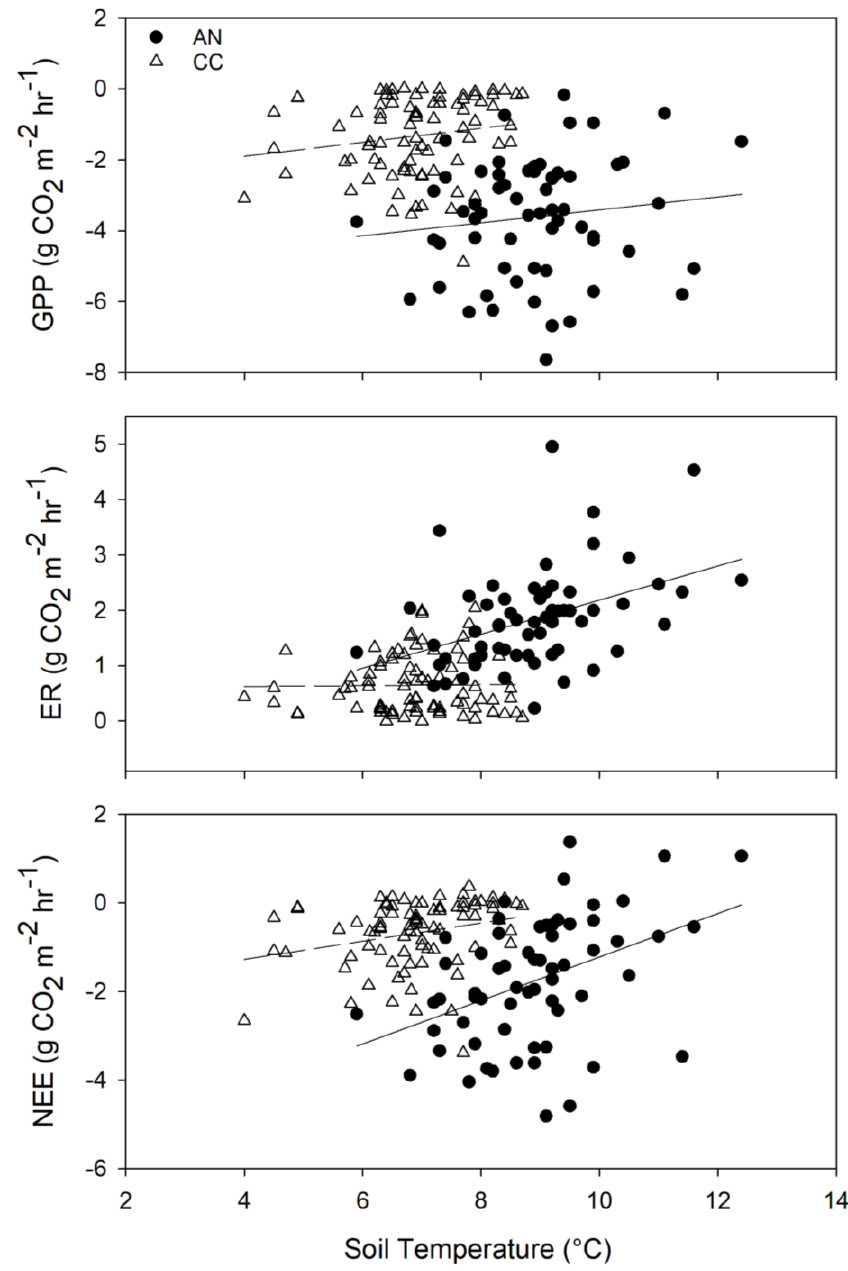
Figure 6. Correlations between gross primary production (GPP) (top), ecosystem respiration (ER) (bottom) (g CO m -2 hr -1 ) and soil temperature ( ° C) at 5 cm depth for Cayambe Coca (CC) and Antisana (AN). Note 2 that AN values only included collars with 100 % vegetation